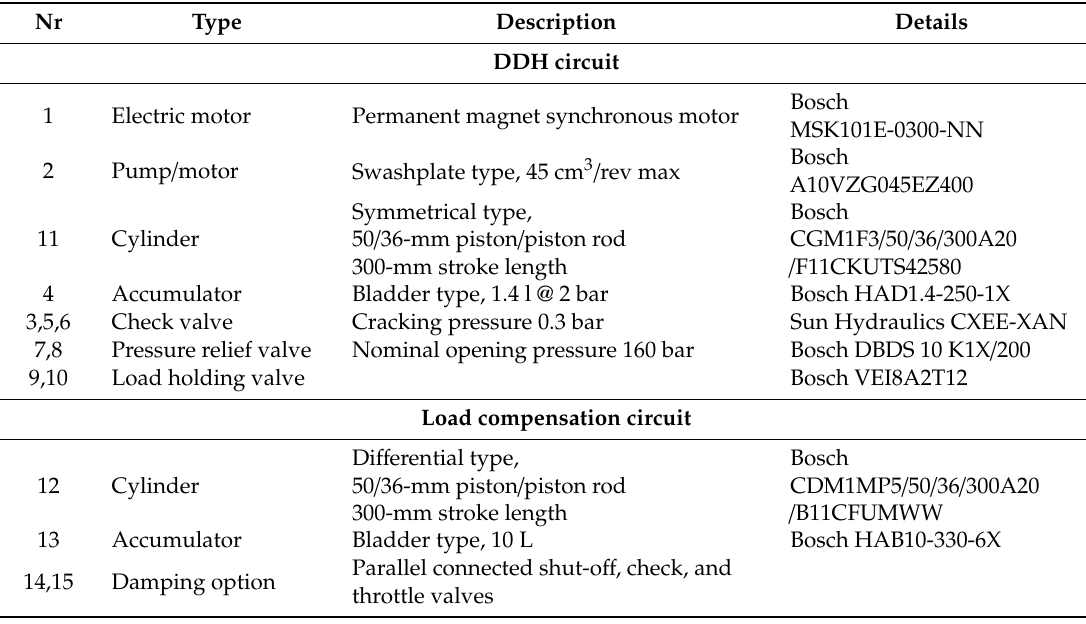
Table 1. Fluid power components of the test rig.